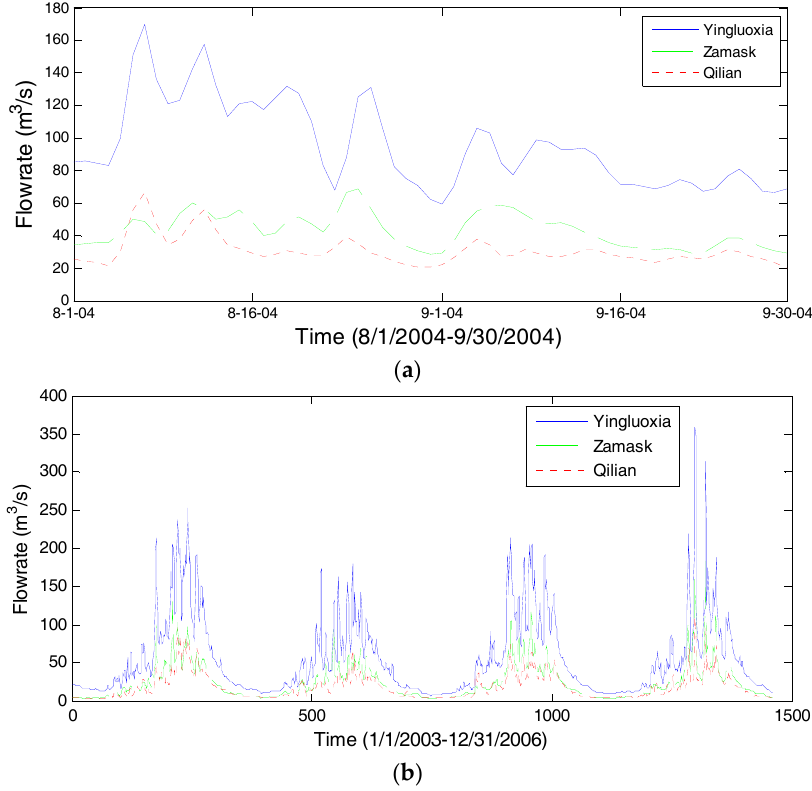
Figure 6. Measured flows from hydrologic stations with upstream inflows from Zamask and Qilian stations: ( a ) flow from August to September 2004; ( b ) flow from January 2003 to December 2006.